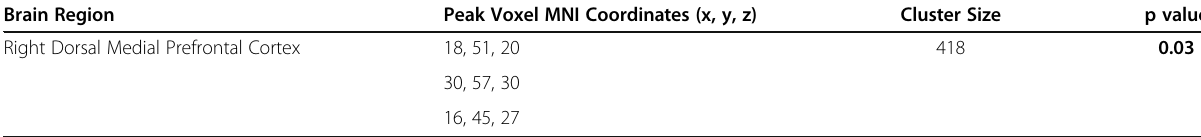
Table 2 Decreased GMV from whole brain analyses comparing EM patients with and without prior clinical care Brain Region